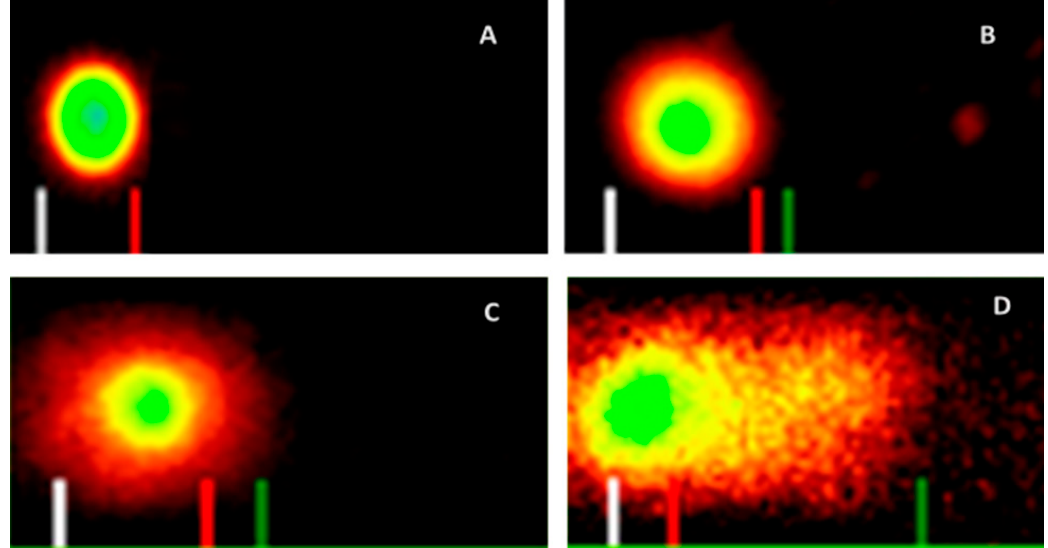
Figure 6. Representative SYBR green comet assay images of untreated ( A -control) and Vernonia calvoana fraction 7 (VC F7)-treated cells at 8 µg/mL ( B ), 16 µg/mL ( C ), and 32 µg/mL ( D ) for 48 hours.